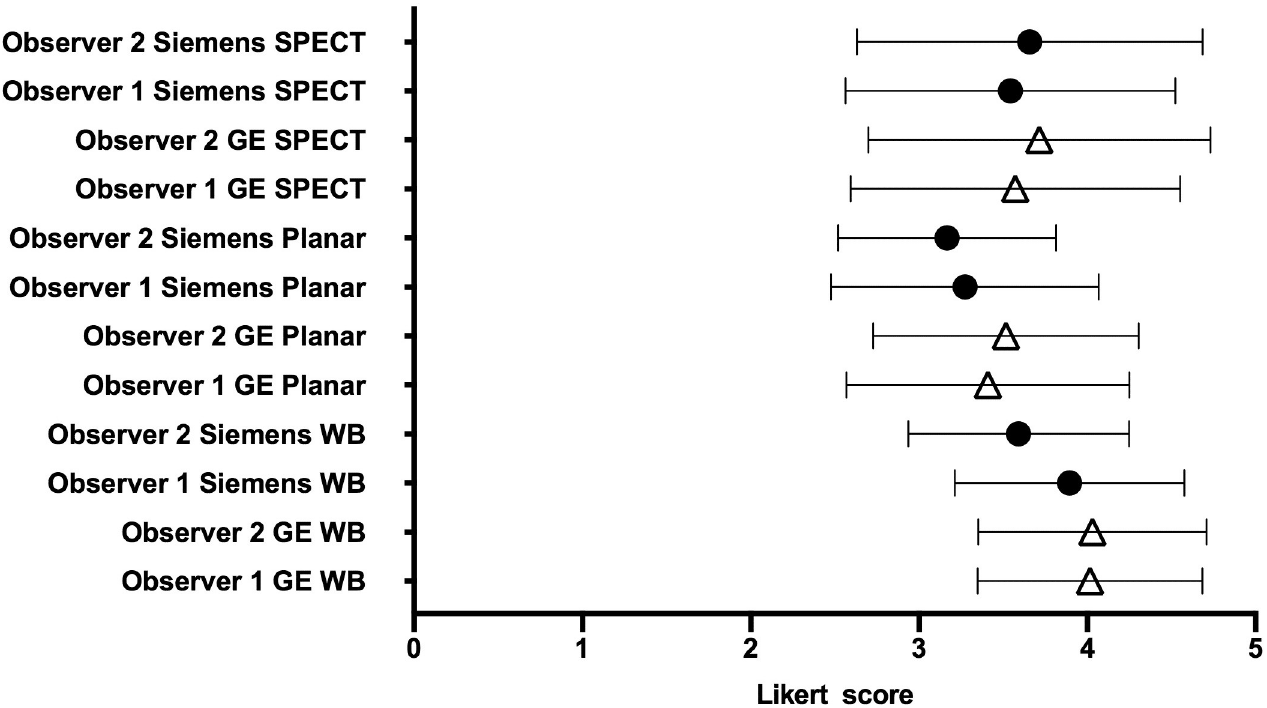
Fig 6. Bland-Altman representation of image